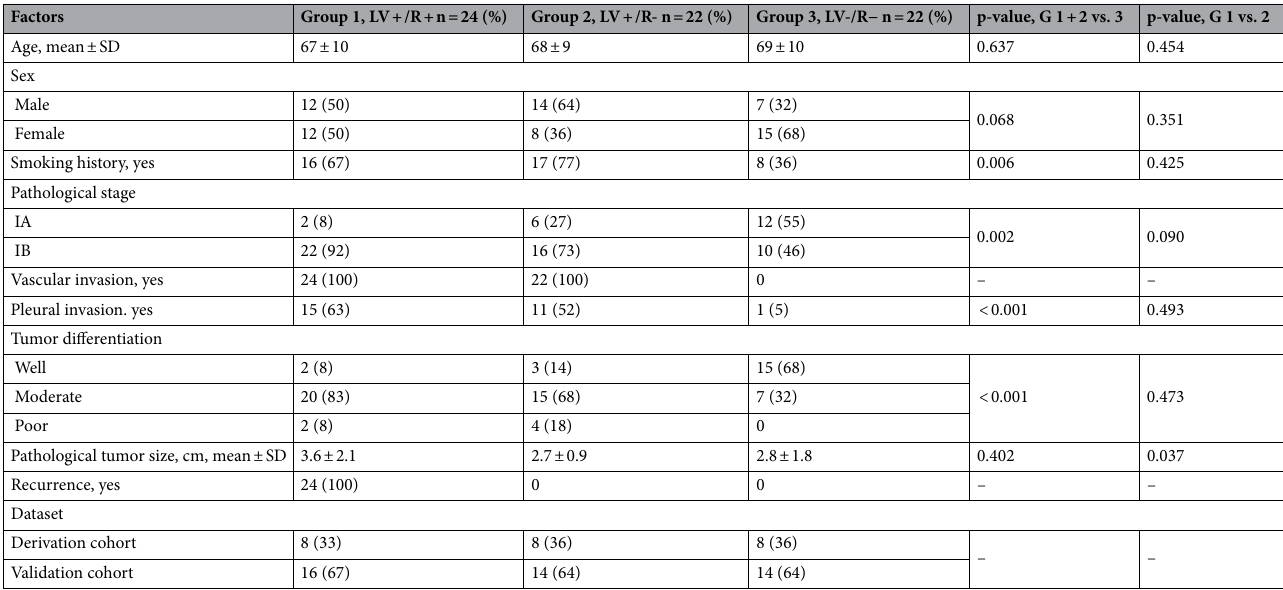
Table 1. Characteristics of patient groups (n = 68). LV lymphovascular invasion, R recurrence within 2 years after surgery, SD standard